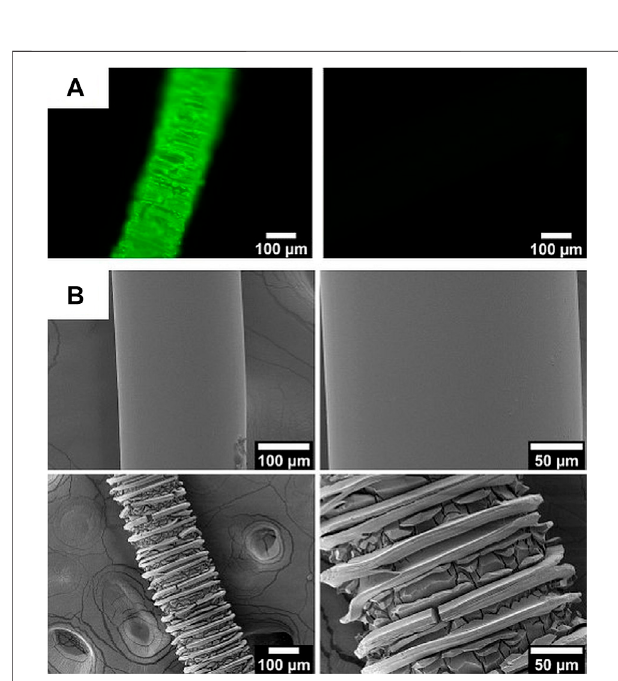
FIGURE 4 | (A) Fluorescence microscopy images of aminolyzed (left) and control fi bers (right) after treatment with FITC. (B) SEM images of unmodi fi ed (top) and amino-modi fi ed fi bers (bottom) at two different magni fi cations.